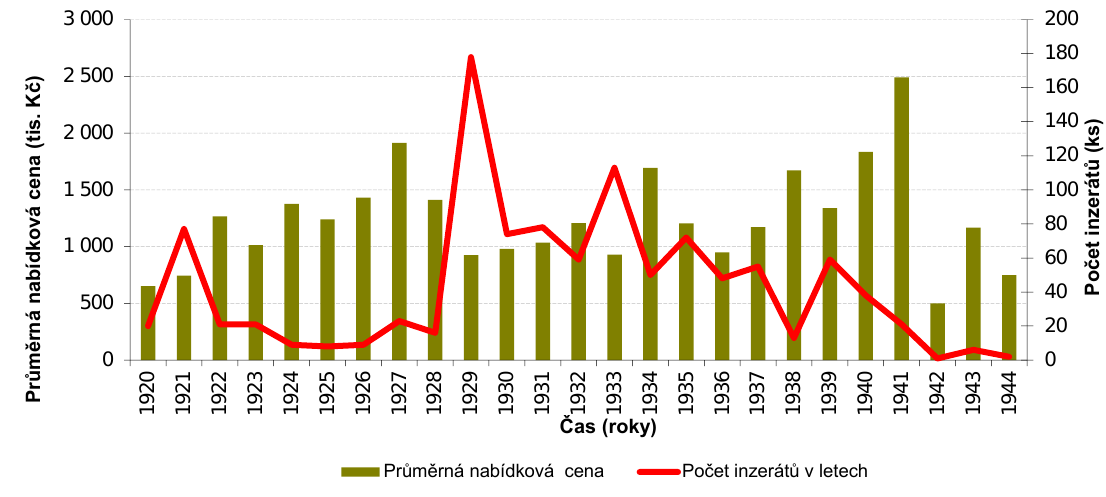
Obrázek 12: Průměrná nabídková cena a počet nabídek pro bytový dům v Praze. Obrázek 12 zobrazuje vývoj průměrné ceny bytového domu v Praze a počet zaznamenaných inzerátů v jednotlivých letech.